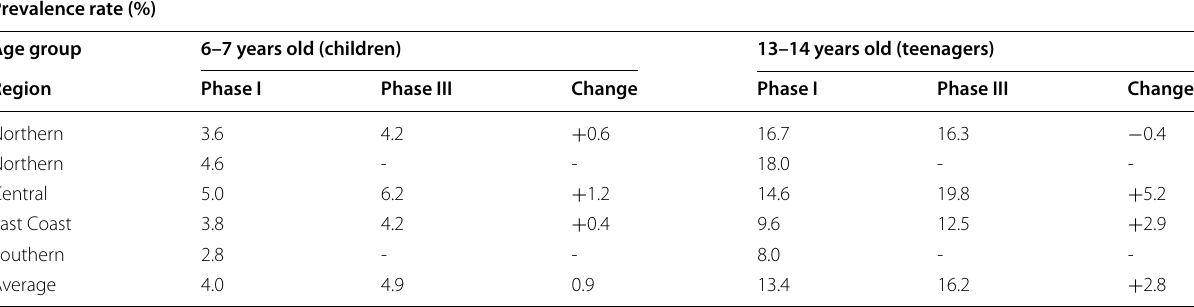
The International Study of Asthma and Allergies in Childhood (ISAAC) was conducted in three separate time frames, namely phase I (1994–1995), phase II (1998) and phase III (2001–2002), respectively [23]. Malaysia was part of phases I and III of the study. (-) indicates data not